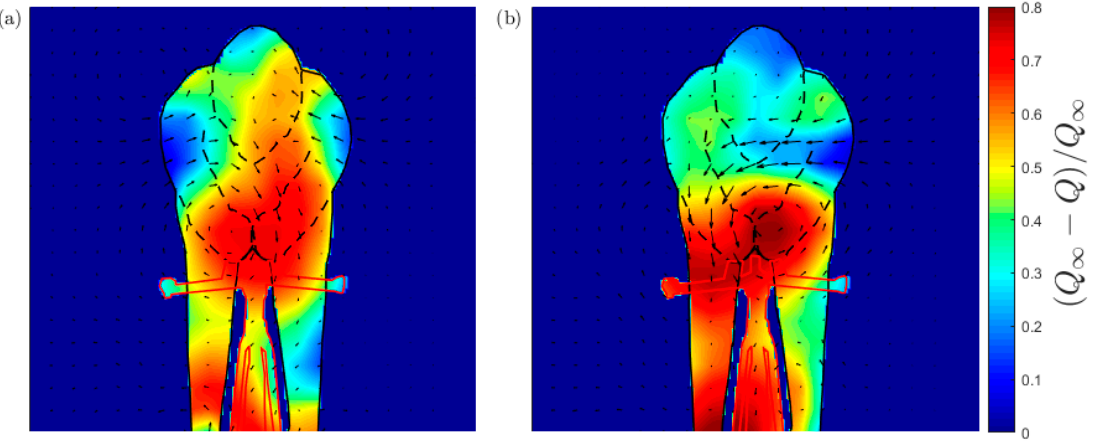
Figure 5. Front view of the integration area of the time-average dynamic pressure savings contour map of the streamwise velocity ( u ) in the Y - Z plane 0.63 m behind a static legged mannequin in the ( a ) 0° leg position; ( b ) 90° leg